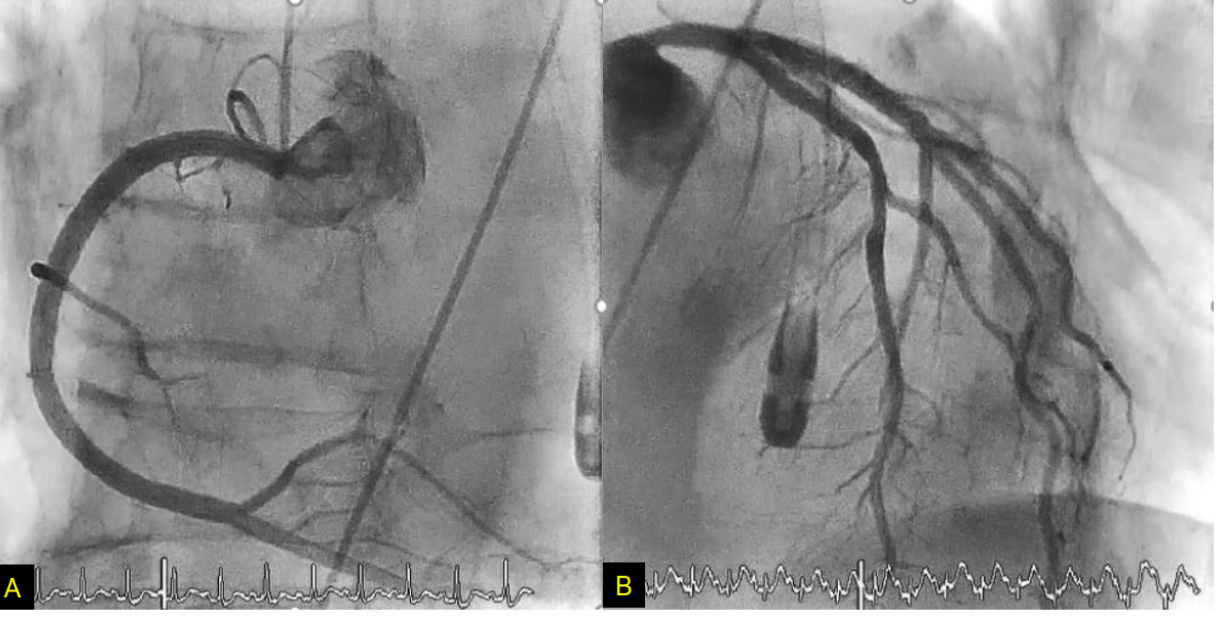
Figure 7. Coronary artery angiography. No stenosis was observed in the right coronary artery ( A ), left anterior descending artery, or circumflex artery ( B ). From [96].